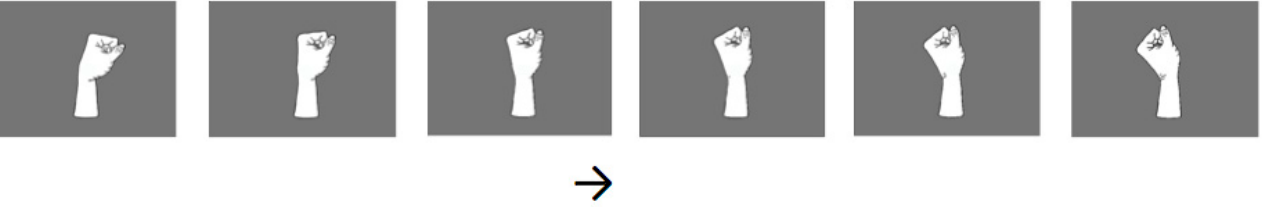
Figure 3. Screenshots of the hand in extension movement clip presented to the participants in the conditions VIS and VIS & KIN.